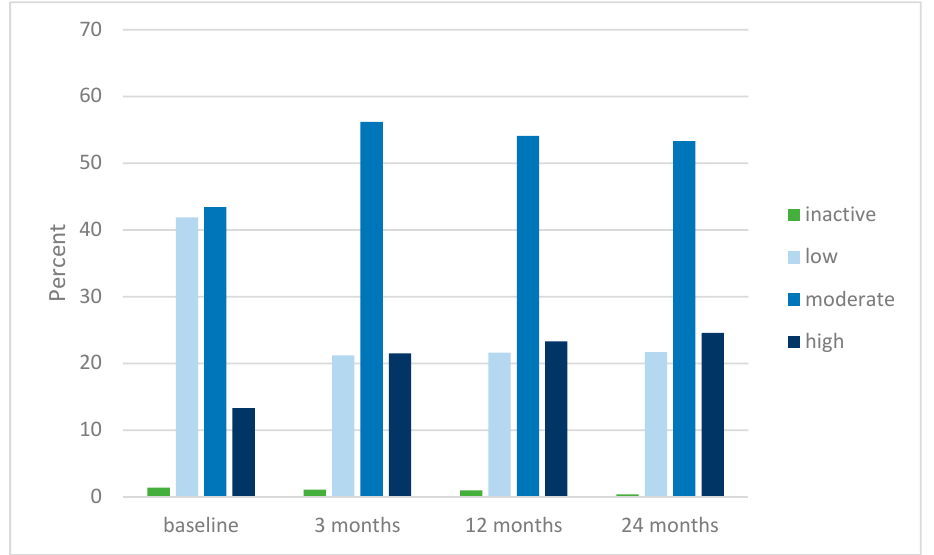
Figure 4. Distribution (given in %) of patient-reported physical activity levels at baseline, 3, 12 and 24 months in patients with knee or hip osteoarthritis who have participated in the Active with osteoArthritis (AktivA) education and supervised exercise program.